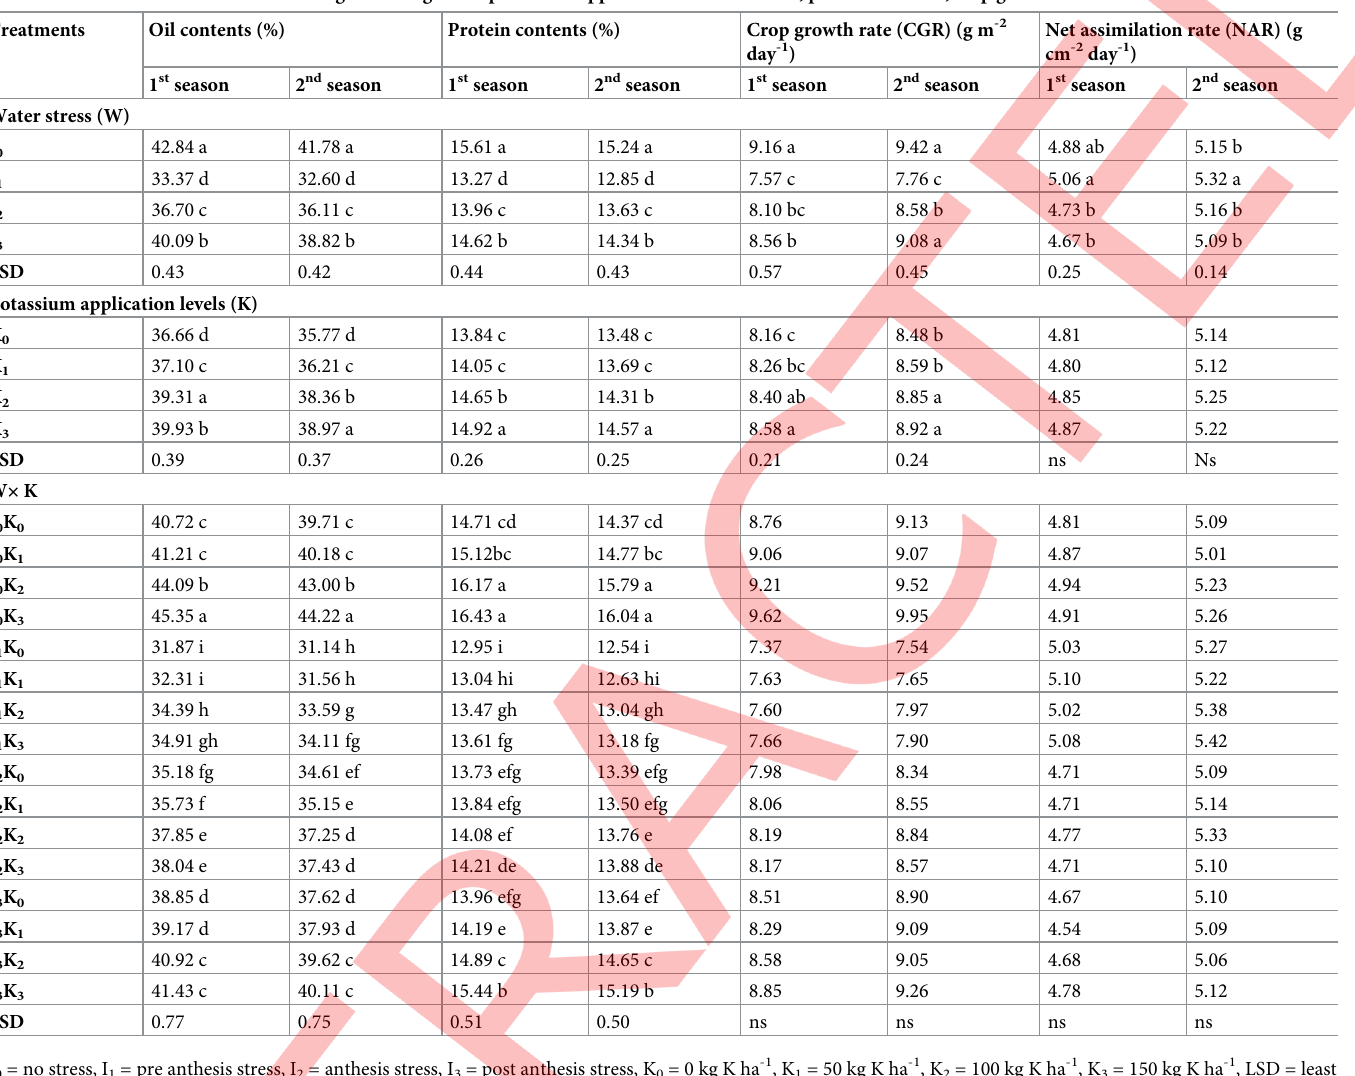
Table 6. Effect of water stress at different growth stages and potassium application on oil contents, protein contents, crop growth rate and net assimilation rate. Treatments Oil contents (%)